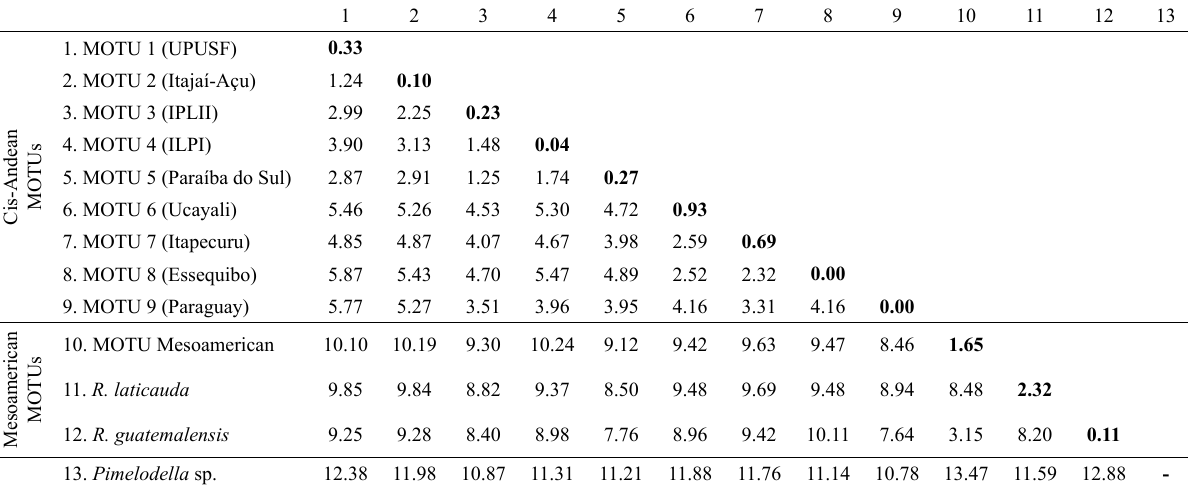
Table 1 – The mean intra-MOTU (in bold) and inter-MOTU genetic distances of Rhamdia lineages are based on the COI gene and the K2P model. Values are presented in percentage. UPUSF (Upper Paraná-Uruguay-São Francisco basins); IPLII (Iguaçu ( R. voulezi )-Peri Lagoon-Itapocu); ILPI (Iguaçu (R. branneri) -Lower Paraná-Itapocu); MOTU Mesoamerican (MOTU Mesoamerican 1 and Mesoamerican